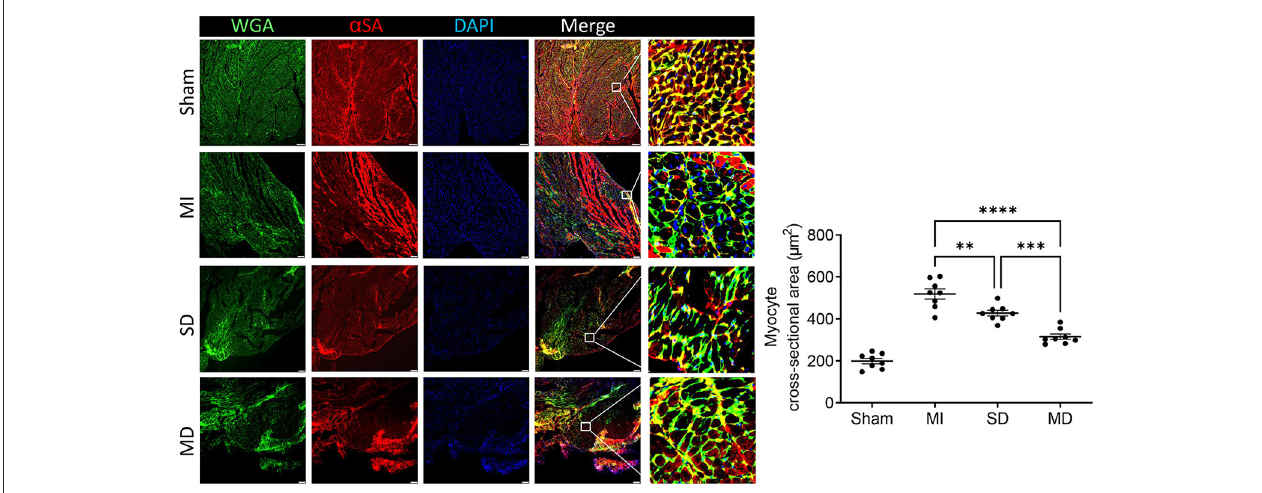
FIGURE 8 | Assessment of left ventricular hypertrophy. Mice in each group were sacrificed 4 weeks after surgery, cardiomyocytes in the peri-infarcted area of the left ventricle were stained with wheat germ agglutinin and α SA, and nuclei were labeled by DAPI. The cross-sectional area of the cardiomyocytes was measured and is shown as an absolute value. Scale bar = 10 µ m. One-way ANOVA with Dunn’s multiple comparisons test. ** p < 0.01; *** p < 0.001; **** p <